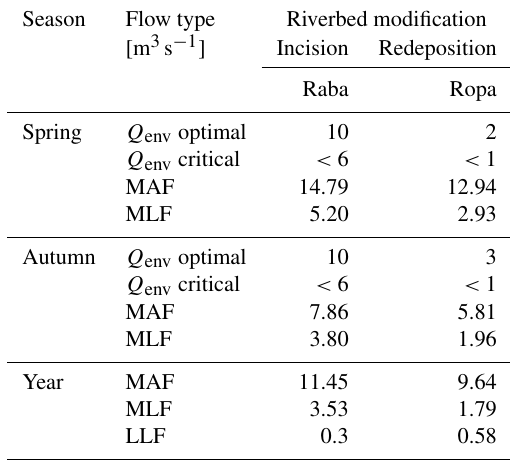
Table 6. Environmental optimal and critical flow based on macroin- vertebrate habitat suitability models of two mountainous rivers with mean MAF, MLF, and LLF in relation to the